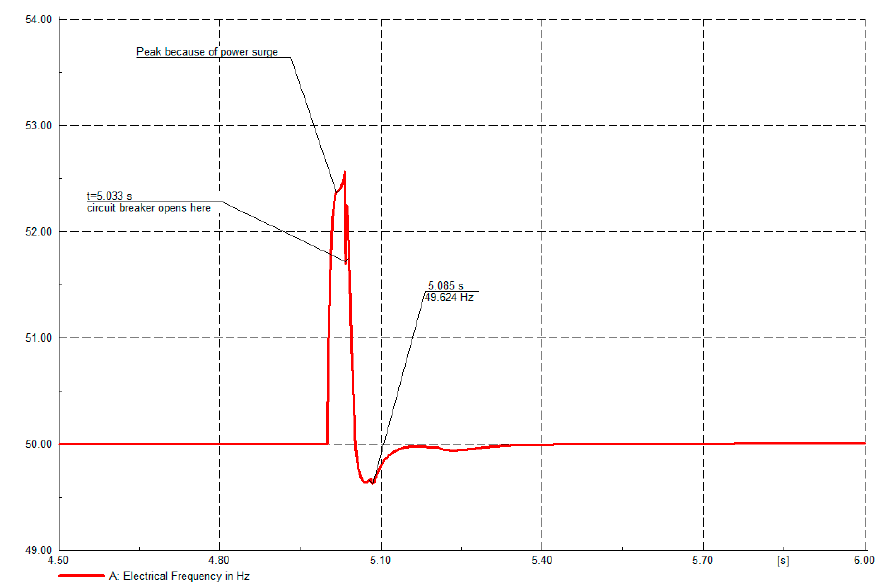
Table 3. The power production and the power during island mode